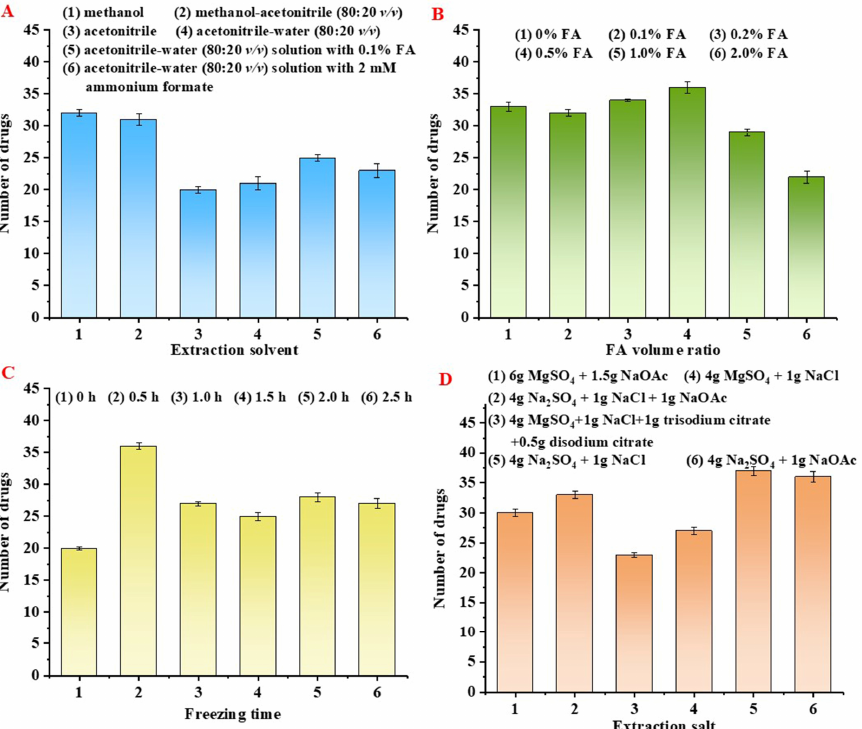
Figure 2. Effects of different extraction factors. ( A ) The effects of different extraction solvents; ( B ) The effect of the acidity of the extraction solvent; ( C ) The effect of freezing time; ( D ) The effect of extraction salt.